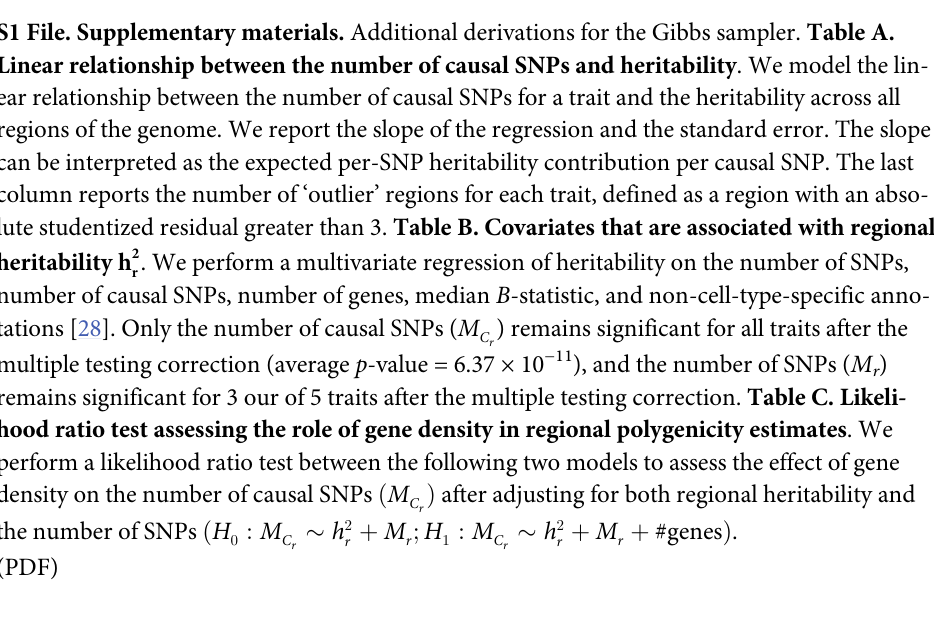
S6 Fig. Heritability is proportional to the number of causal SNPs in a region. We show the relationship between the number of causal SNPs and heritability for each region across BMI, waist-hip ratio (WHR), and systolic blood pressure. We fit a linear regression for each trait. Horizontal error bars represent two posterior standard deviations around our estimates for the number of causal SNPs. Vertical error bars represent twice the standard error around the esti- mates of regional heritability. Dots in black denote outlier regions which have an absolute stu- dentized residual larger than 3. S1 File. Supplementary materials. Additional derivations for the Gibbs sampler. Table A. Linear relationship between the number of causal SNPs and heritability . We model the lin- ear relationship between the number of causal SNPs for a trait and the heritability across all regions of the genome. We report the slope of the regression and the standard error. The slope can be interpreted as the expected per-SNP heritability contribution per causal SNP. The last column reports the number of ‘outlier’ regions for each trait, defined as a region with an abso- lute studentized residual greater than 3. Table B. Covariates that are associated with regional heritability h 2 . We perform a multivariate regression of heritability on the number of SNPs, r number of causal SNPs, number of genes, median B -statistic, and non-cell-type-specific anno- tations [28]. Only the number of causal SNPs ( M ) remains significant for all traits after the C r multiple testing correction (average p -value = 6.37 × 10 − 11 ), and the number of SNPs ( M ) r remains significant for 3 our of 5 traits after the multiple testing correction. Table C. Likeli- hood ratio test assessing the role of gene density in regional polygenicity estimates . We perform a likelihood ratio test between the following two models to assess the effect of gene density on the number of causal SNPs ð M Þ after adjusting for both regional heritability C r